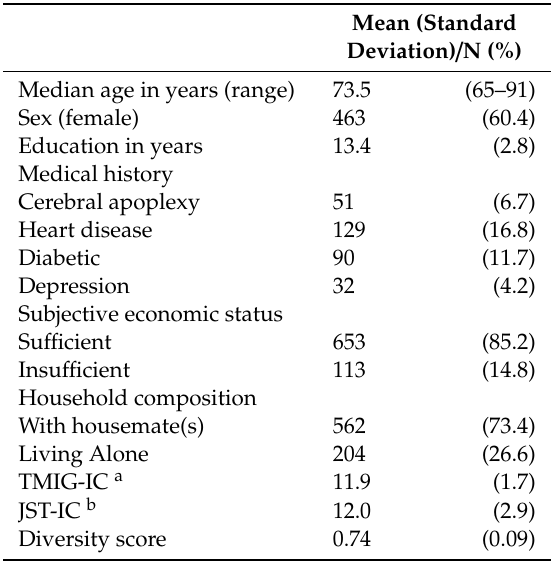
Table 2. Participant characteristics.